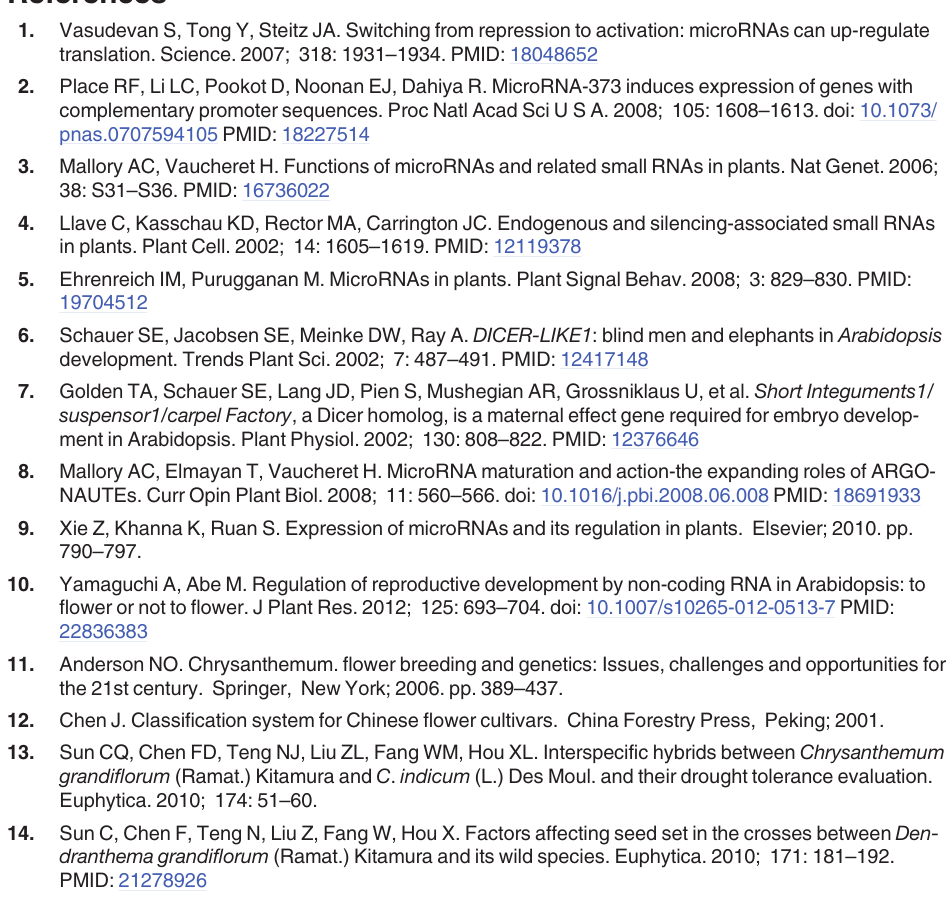
S1 Table. Primers used for qRT-PCR. S2 Table. 5' RACE PCR primer sequences